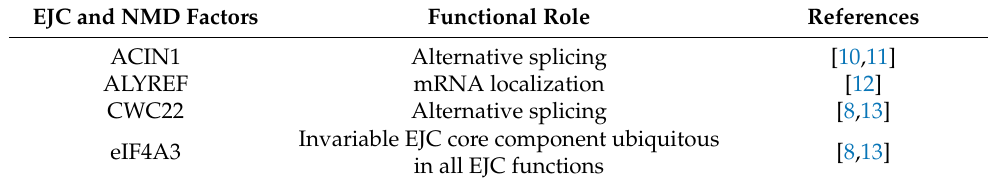
Table 1. EJC core and major peripheral components associated with functional roles in context of various EJC functions. Included are key references in which EJC component structural integration is